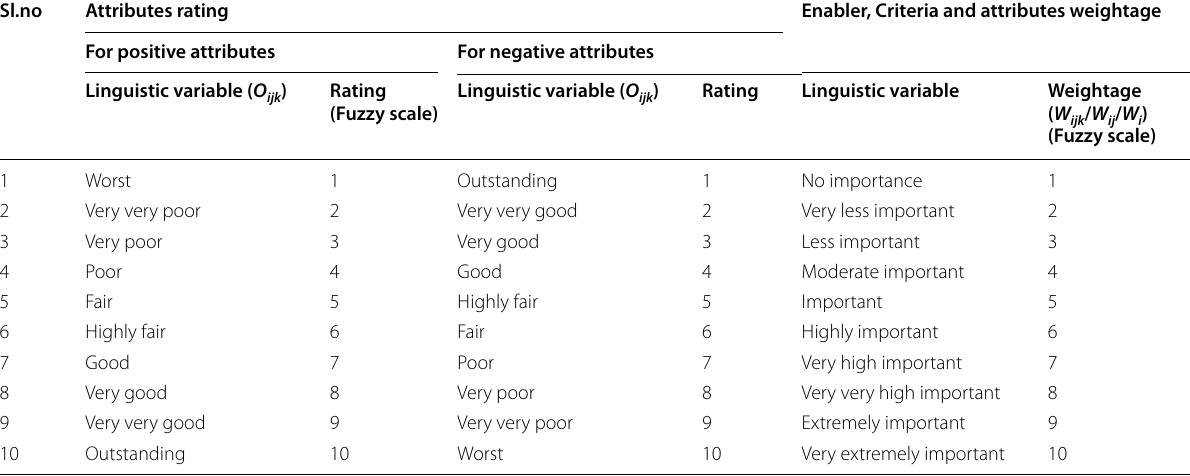
Table 3 Rating and weight-scale for work-from-home for software professionals Sl.no